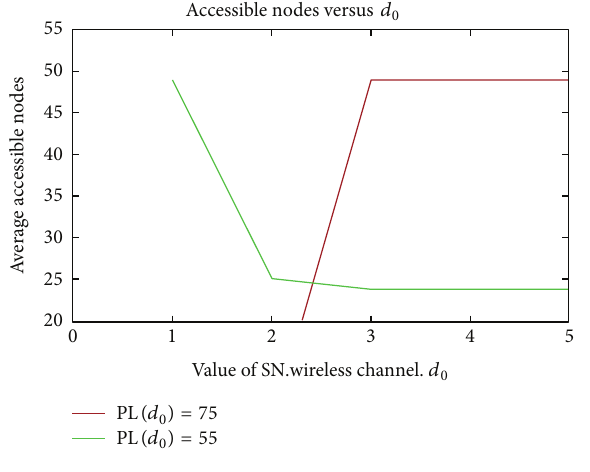
Figure 10: Reference distance.